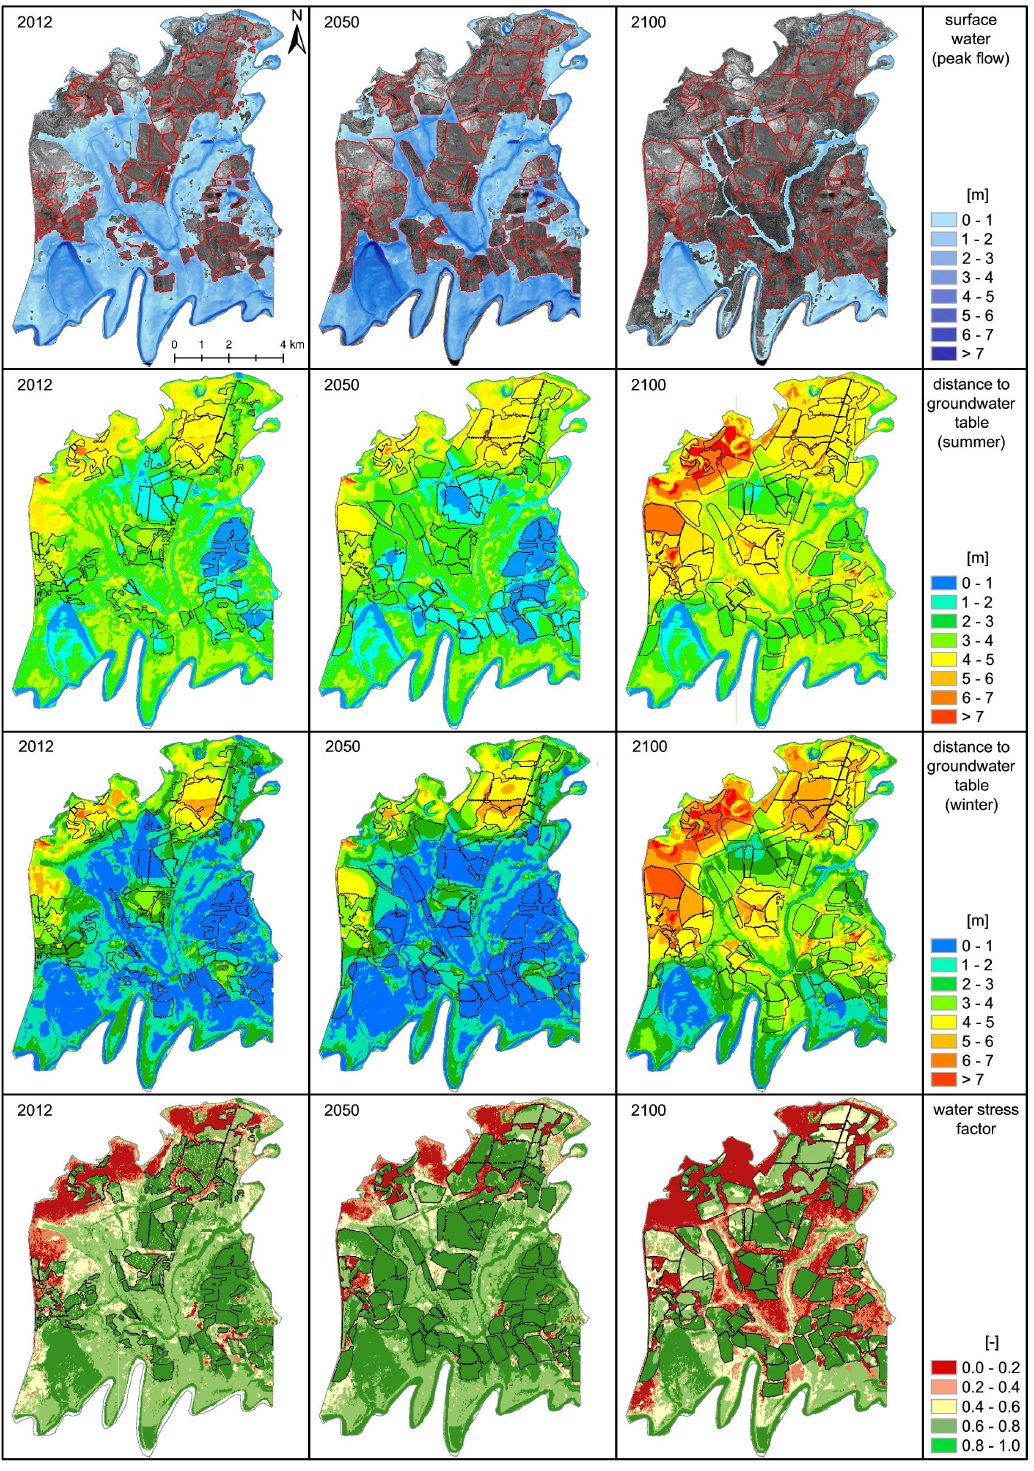
Figure 6. Effects of land-use and climate change in the future (2050 and 2100) on flooding, distance to groundwater table in summer and winter, and water